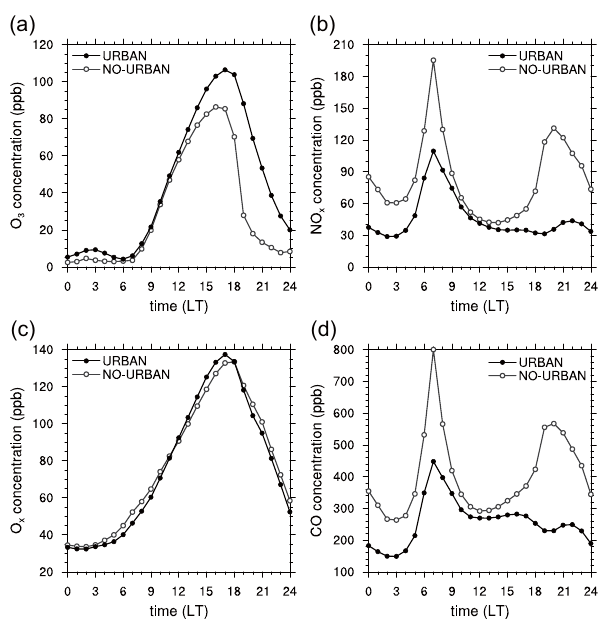
Fig. 5. Diurnal variations of near-surface concentrations of (a) O 3 , (b) NO x , (c) O x ( = O 3 + NO 2 ) , and (d) CO averaged over the urban analysis area in the URBAN and NO-URBAN simulations.